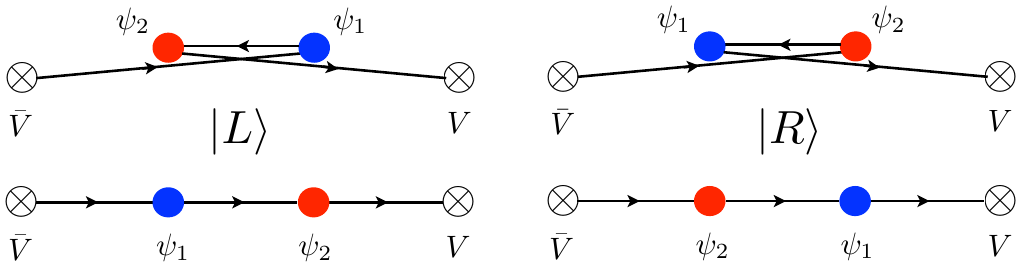
Figure 4 . L and R sectors arise as a consequence of the color ordering. Note that the ordering j i j i of quarks in space does not need to agree with the color ordering. This leads to a possibility of zigzag con(cid:12)gurations, as shown on the